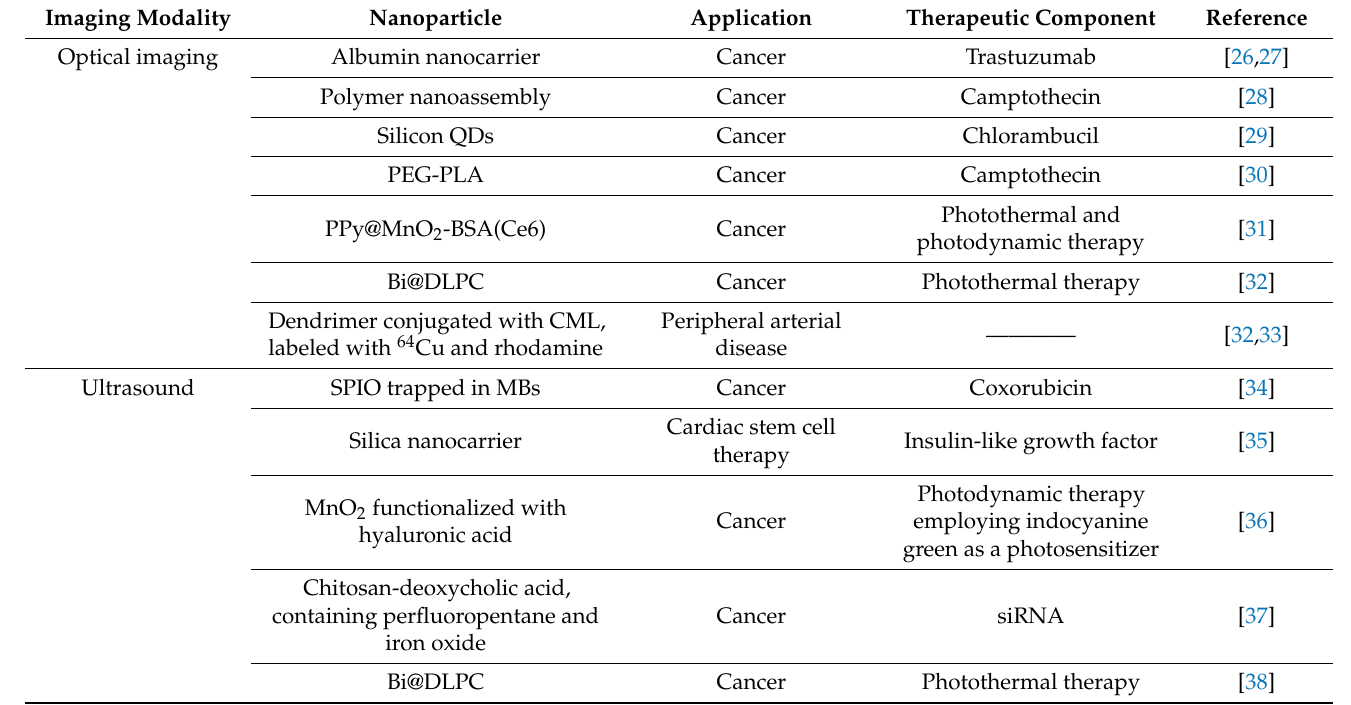
Table 1. Summary of the depicted studies. Multimodal nanoparticles are listed multiple